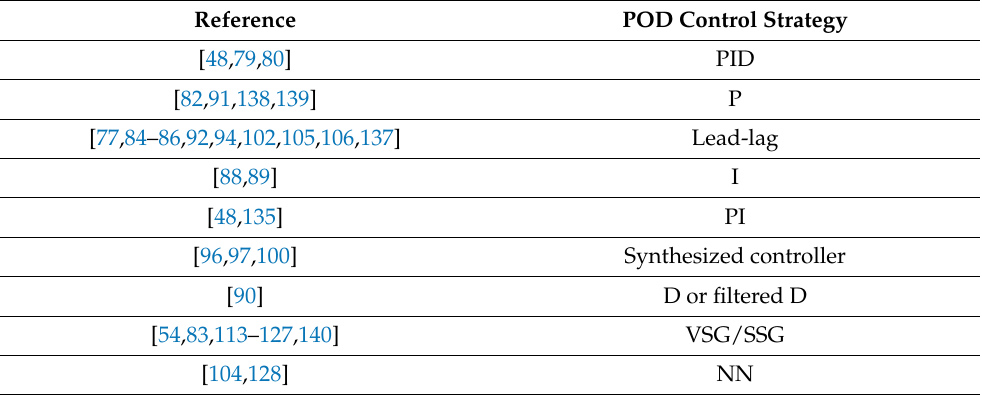
Table 2. POD controller